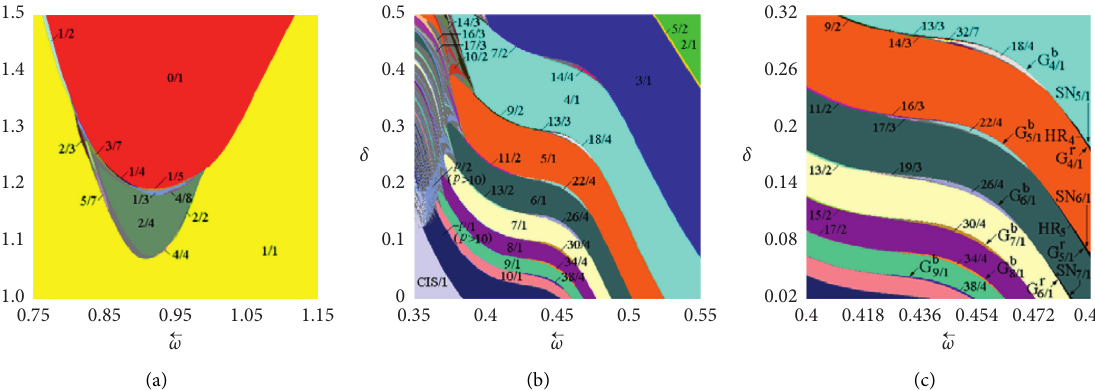
Figure 11: The partial enlargement of Figure 2(b). (a) Tongue-like region: TR (c) tongue-like region: TR